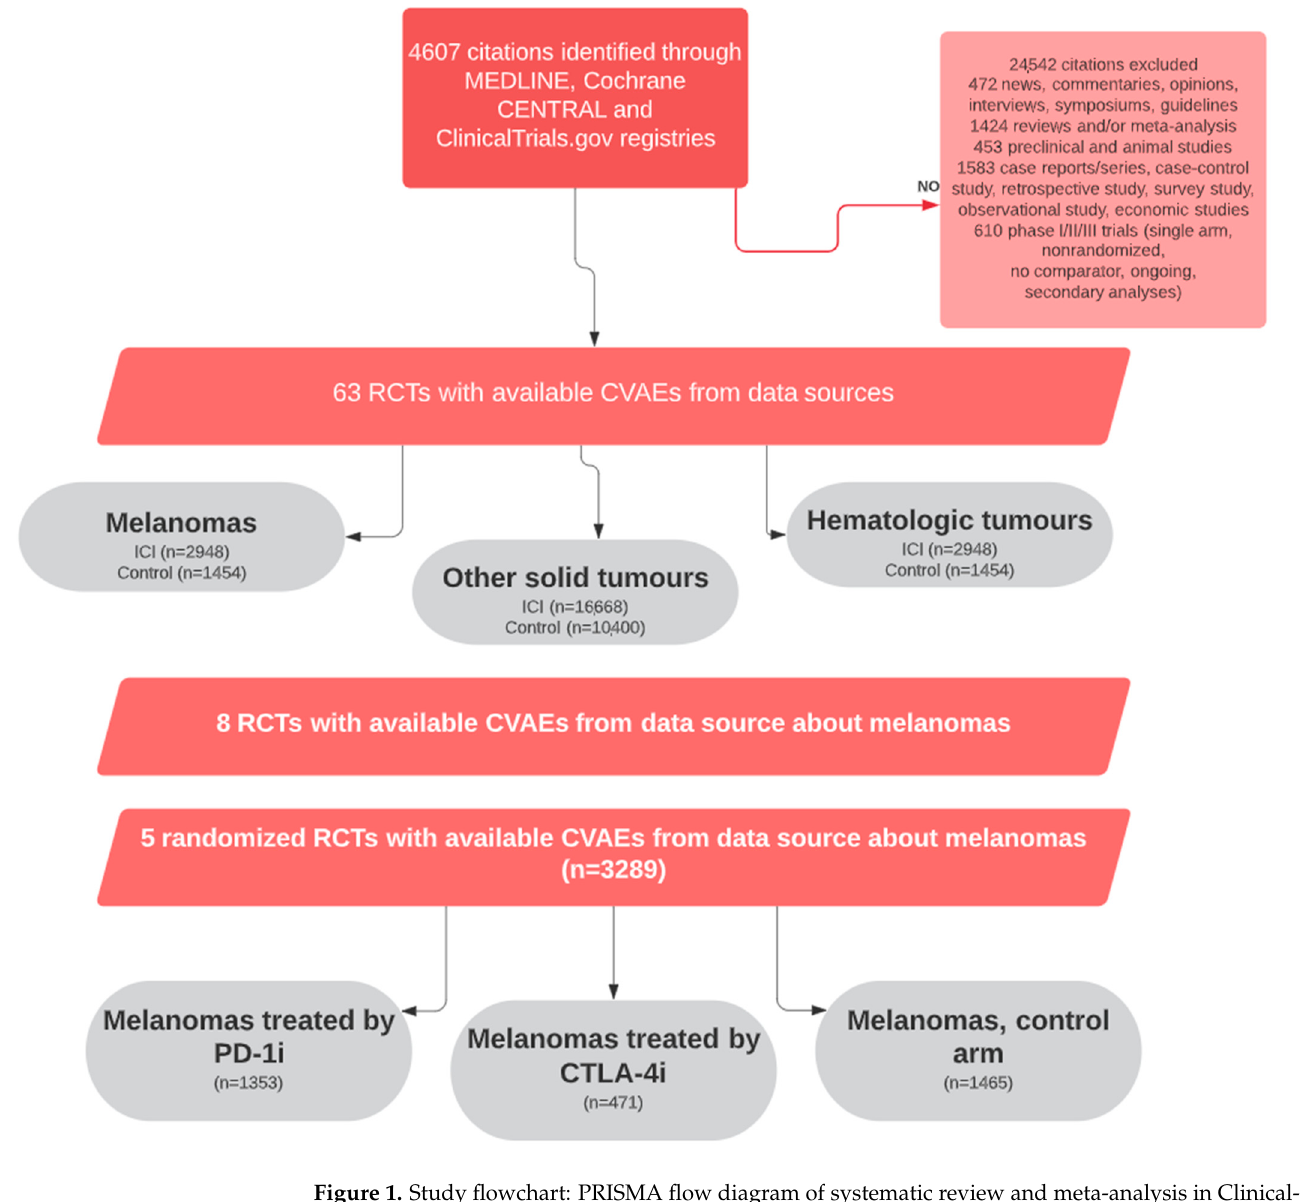
Figure 1. Study flowchart: PRISMA flow diagram of systematic review and meta-analysis in Clinical- Figure 1. Study fl owchart: PRISMA fl ow diagram of systematic review and meta-analysis in Clini- Trials.gov registries, Medline, and Cochrane CENTRAL up to 7 April calTrials.gov registries, Medline, and Cochrane CENTRAL up to 7 April 2020.